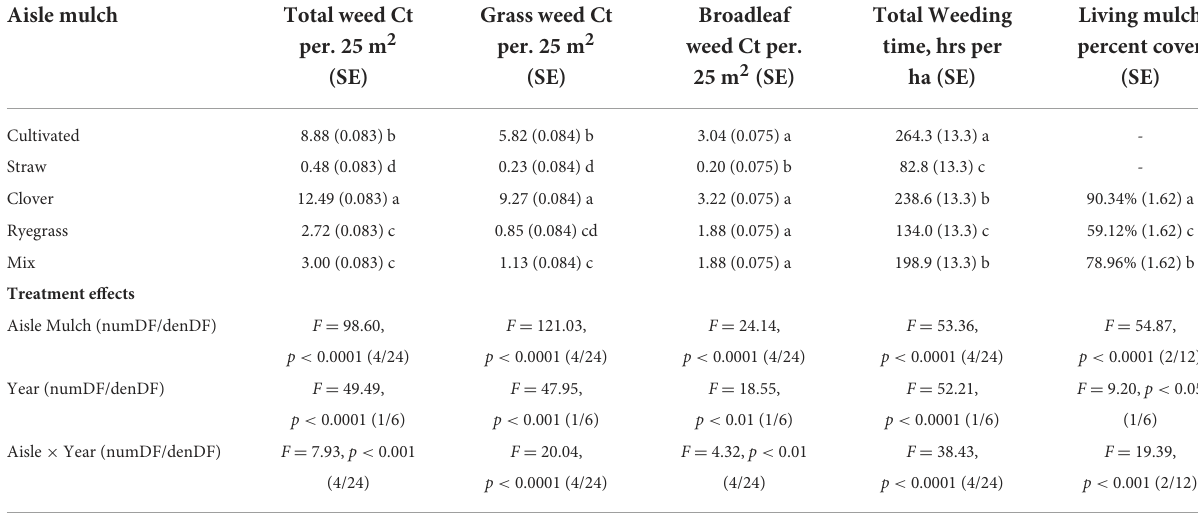
TABLE 5 Least square means of cumulative weed counts and management required for organic zucchini plots grown using living mulch treatments. Aisle mulch